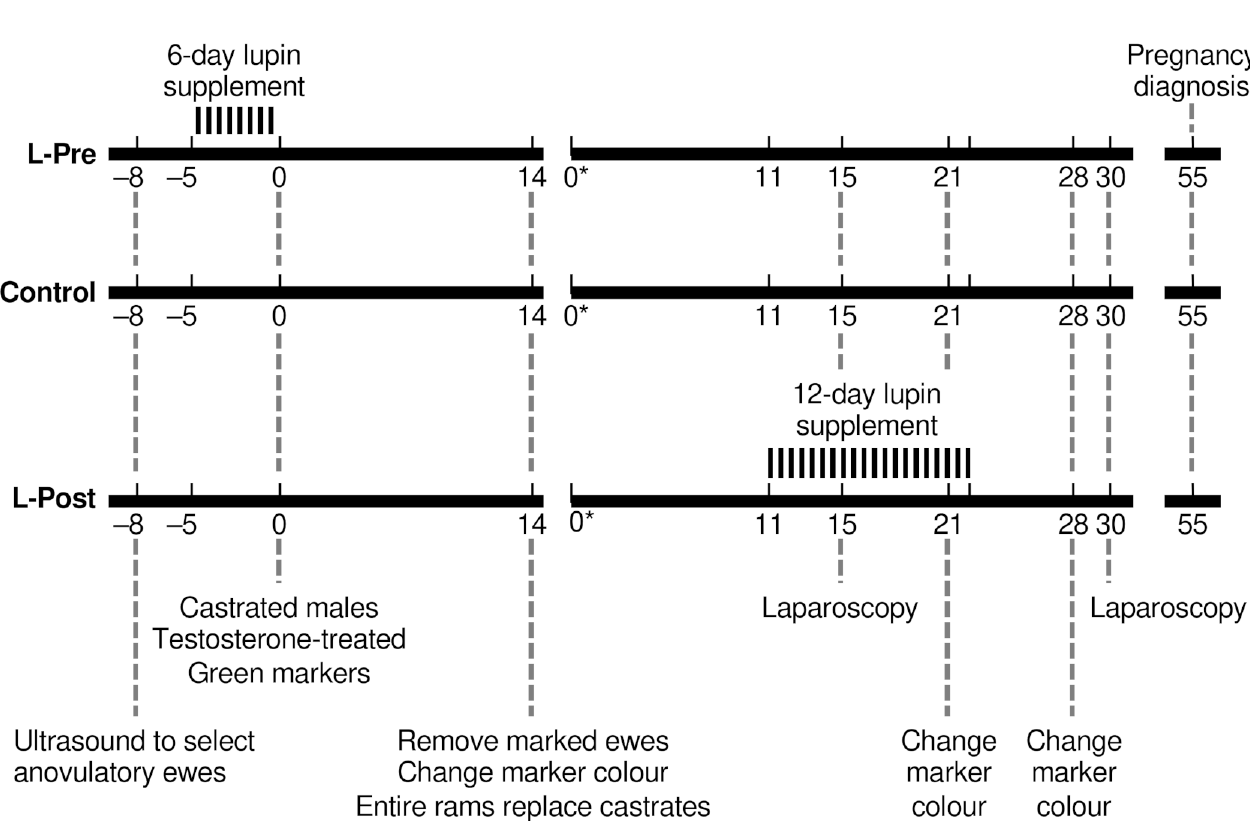
Figure 1. The protocol for Experiment 1. The Control and L-Post groups were run together, and separated from the L-Pre group, until Day 0 (the final day of supplementation for L-Post, and the day males were introduced). Day 0* is the supposed time of ovulation for the second male-induced